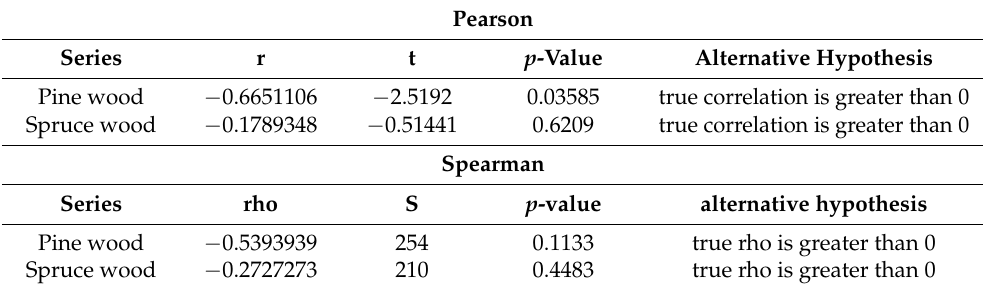
Table 4. Results of the non-parametric test of the correlation coefficient significance.